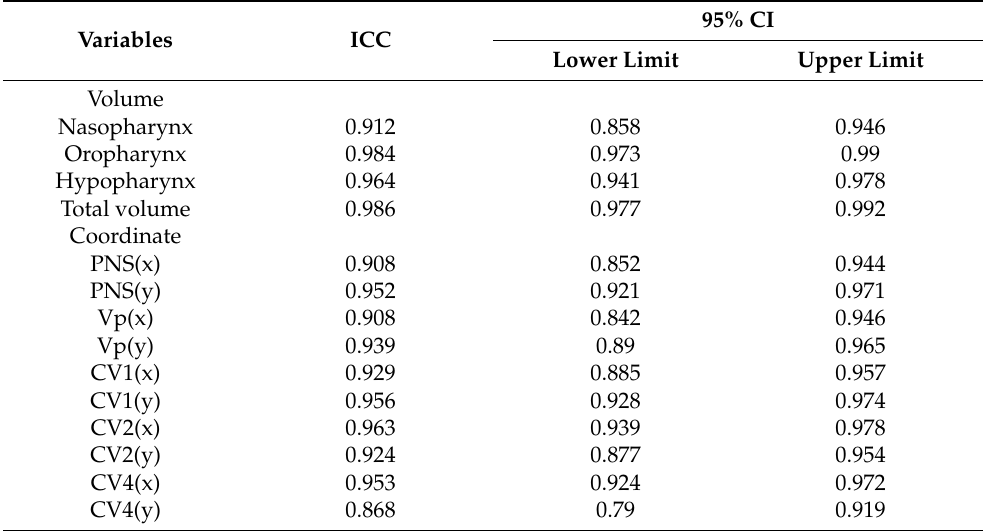
Table 3. Agreement analysis of the volume and point via intra-class correlation coefficient (ICC) (Two-way random effects, absolute agreement, single rater/measurement) (N = 61).